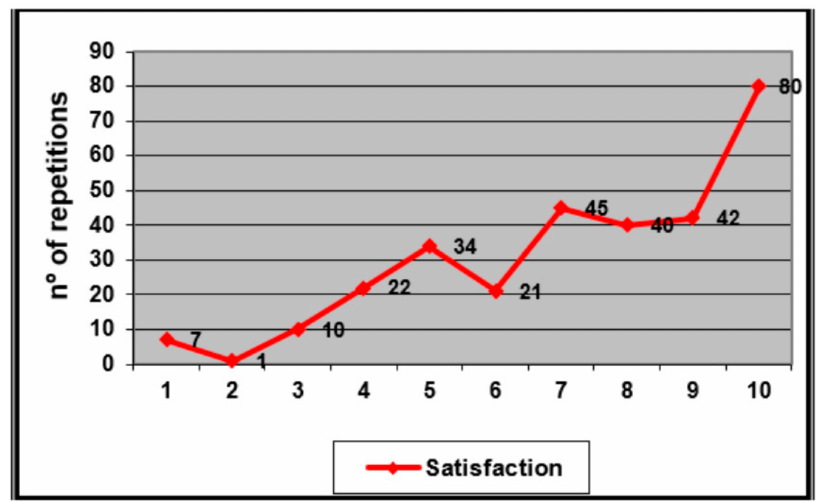
Figure 7. Satisfaction with men supervisors, 2019. Source: Compiled by the